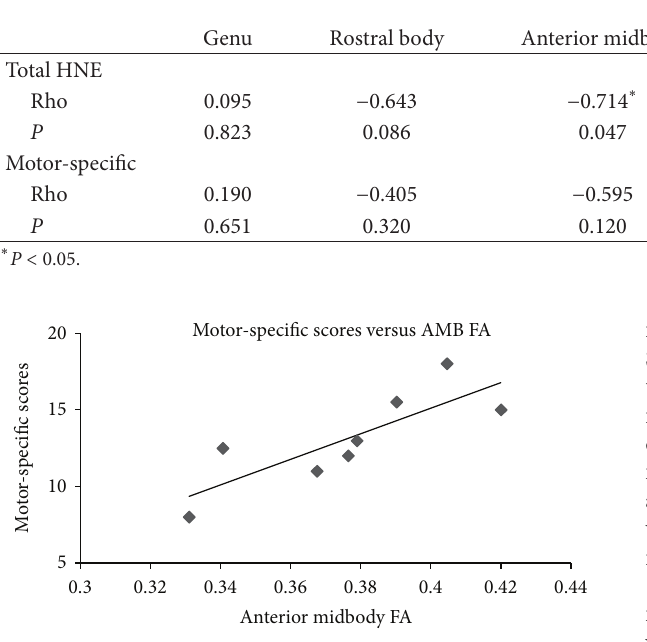
F 4: Scatterplot of motor-speci�c scores and anterior